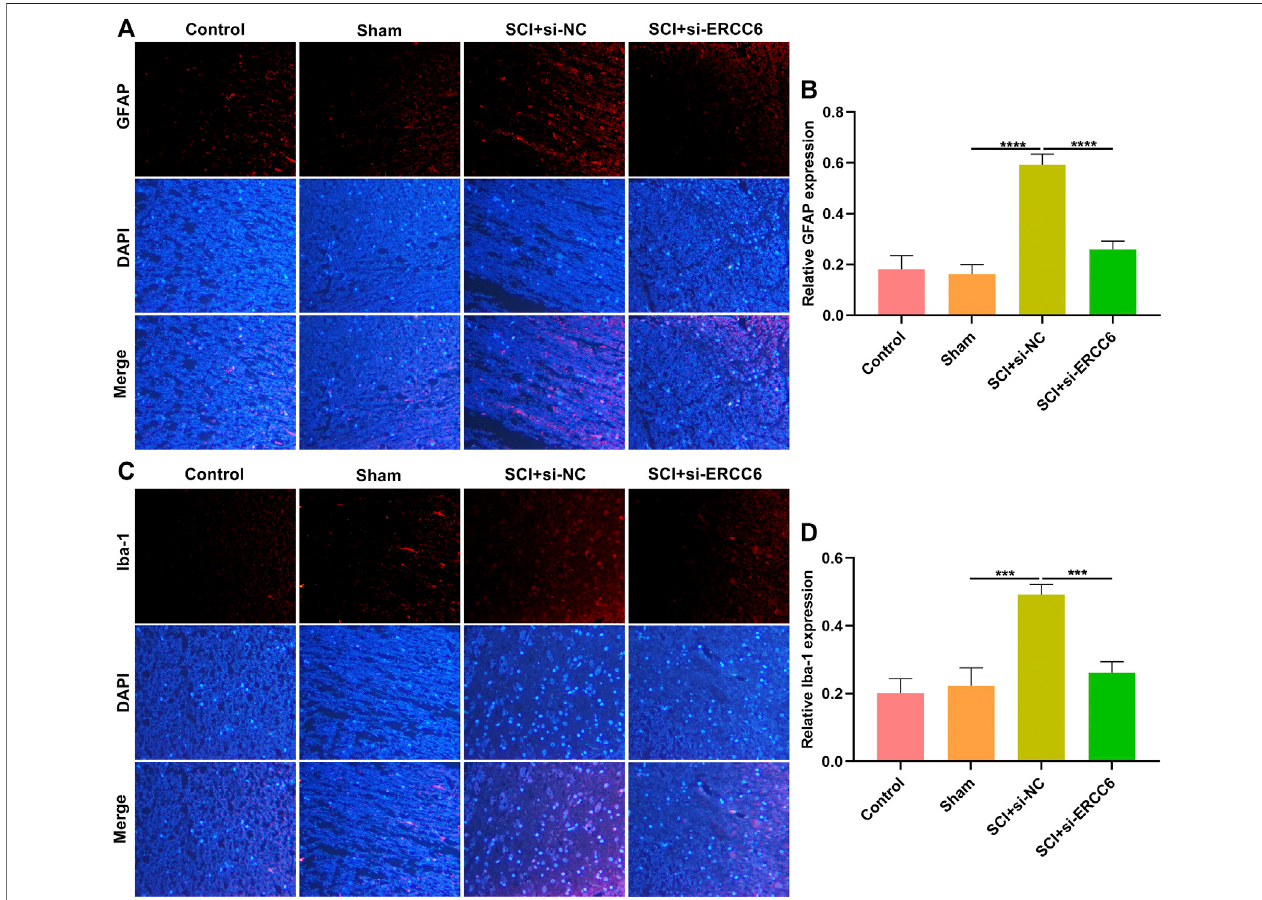
FIGURE 5 | ERCC6 ablation alleviates astrocyte and microglia activation in the spinal cord of SCI mice. (A,B) Immuno fl uorescence staining of GFAP expression in thespinalcordtissuesofSCImiceinjectedwithsi-ERCC6orsi-NCaswellascontrolandshamoperationmice(scalebar,50 μ m). (C,D) Immuno fl uorescencestainingof Iba-1 expression in the spinal cord of mouse models injected by si-ERCC6 or si-NC as well as control and sham operation mice (scale bar, 50 μ m; N = 8 mice in each group). p -values were calculated with the ANOVA test. *** p -value < 0.001; **** p -value < 0.0001.